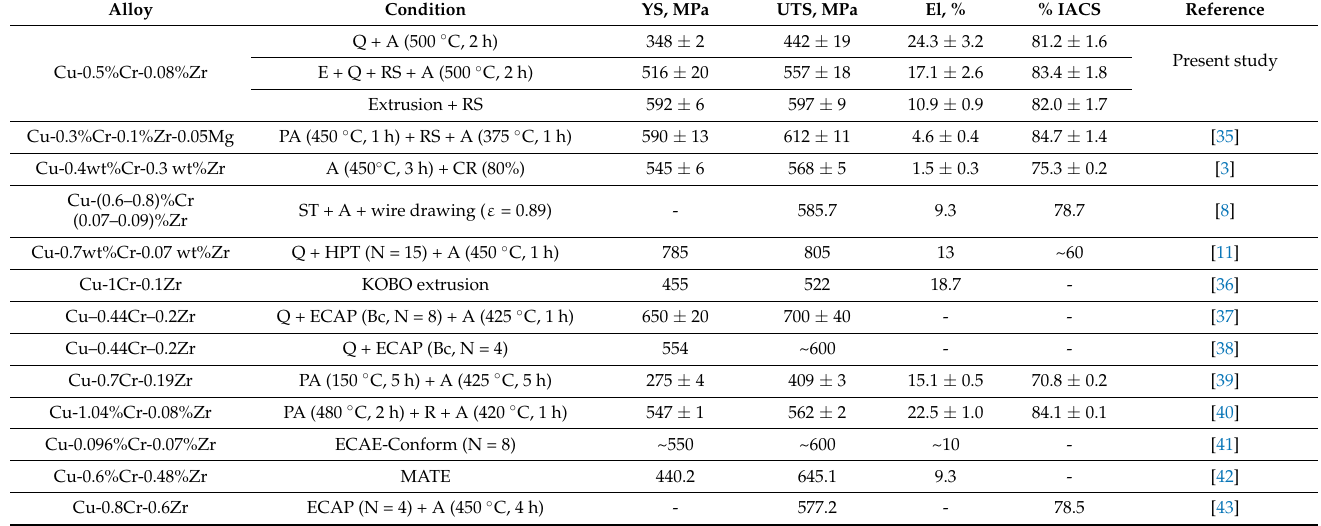
Table 3. Mechanical properties of Cu-Cr-Zr alloys (E—extrusion; Q—quenching; A—aging; PA—pre- aging; R—rolling; CR—cold rolling; ST—solution treatment; HPT—high pressure torsion; ECAP—equal channel angular pressing; MATE—multi-angular twist channel